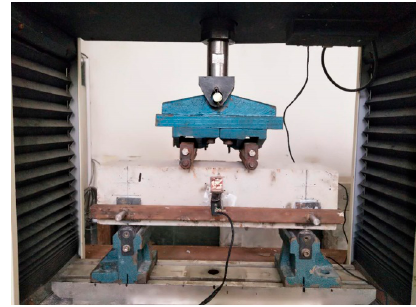
Figure 7. Test set-up for four-point-bending beam.